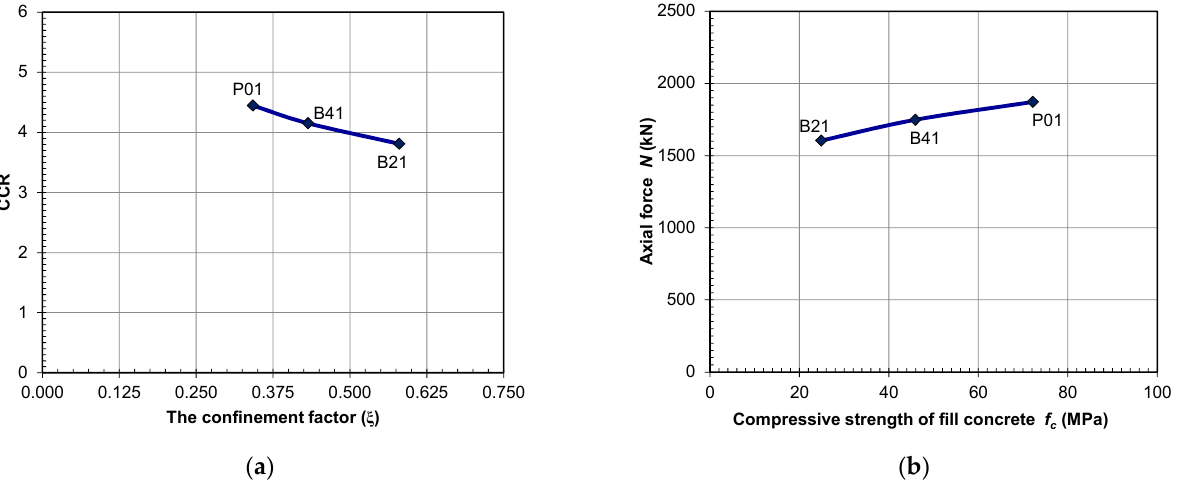
Figure 19. ( a ) Confinement factor versus concrete contribution ratio relationship. ( b ) Effects of test parameters for strengthened columns.